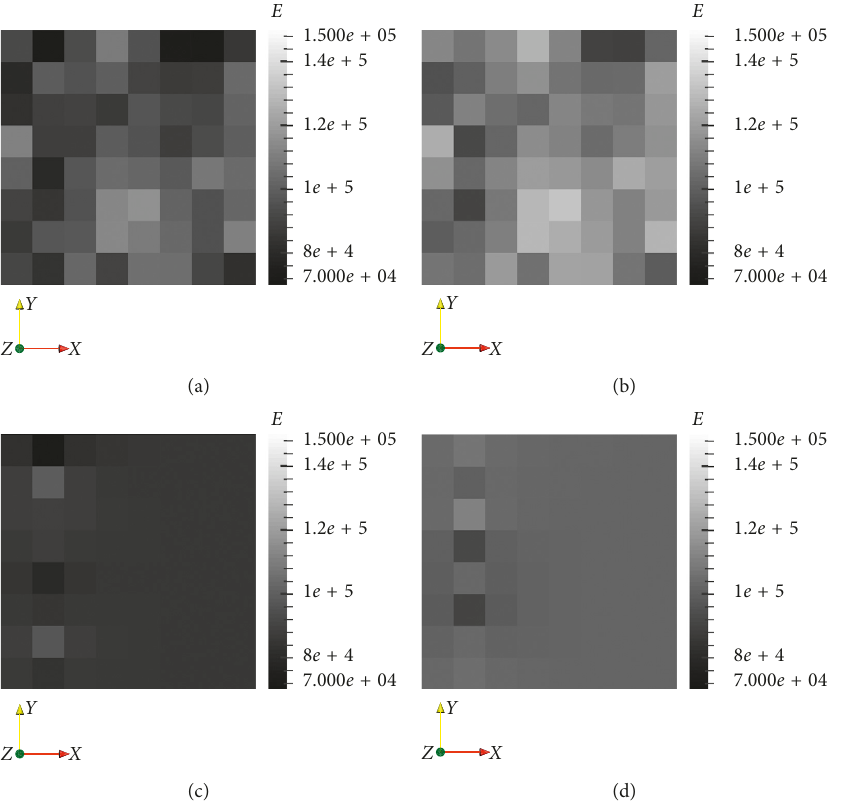
Figure 2: Example realisation i for unconditional field (a), conditional field (b), kriged field based on random field values at measurement locations (c), and kriged field based on measurement values (d), 1